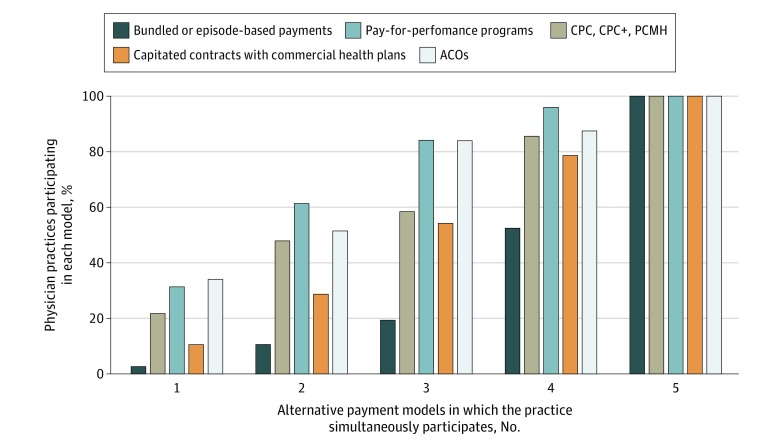
Distribution of Alternative Payment Models (APMs) by Model Type Across 2061 Physician Practices Responding to the National Survey of Healthcare Organizations and Systems Physician PracticesAlternative payment models included (1) bundled or episode-based payments; (2) comprehensive primary care (CPC), CPC Plus (CPC+), and patient-centered medical home (PCMH); (3) pay-for-performance programs; (4) capitated contracts with commercial health plans; and (5) accountable care organizations (ACOs) (Medicare, Medicaid, and commercial). Proportions were adjusted for sampling weights. Because the outcome variable measures the number of APMs each practice reported participating in, the only bar that adds up to 100% is the one identifying practices that reported participating in a single APM. When considering the other bars identifying physician practices reporting participation in multiple APMs, the proportions are overlapping and not mutually exclusive; therefore, the sum of proportions in each of these bars exceeds 100%. For example, among physician practices reporting participation in 2 APMs (representing any combination of all 5 selected APMs, 10.6% participate in bundled or episode-based payments (the least common model), 51.5% participate in ACO models, and 61.4% participate in pay-for-performance programs (the 2 most common models). A similar description could be made for physician practices reporting participation in 3, 4, or 5 APMs.